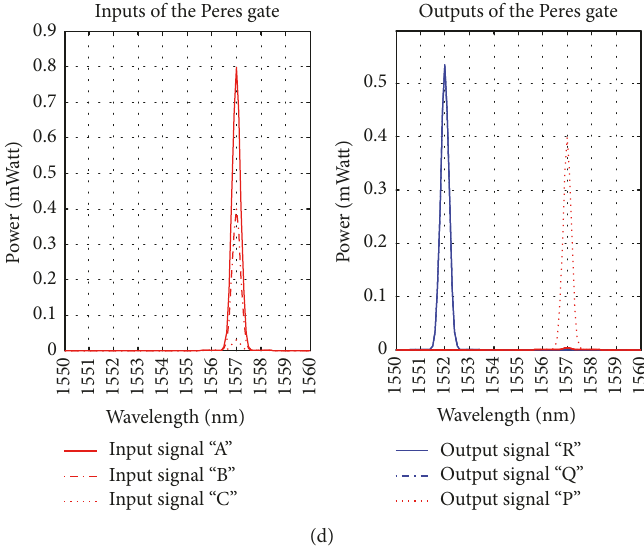
Figure 8: Simulated power spectrum of the optical Peres gate.